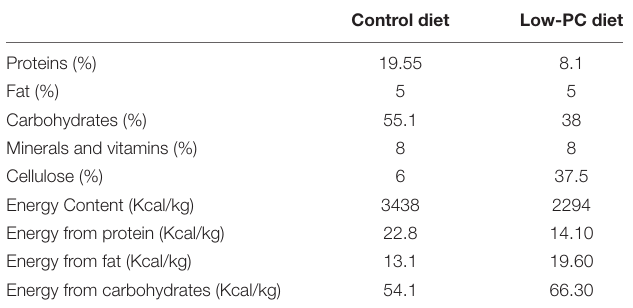
TABLE 1 | Composition of control and low-protein and low-calorie diets.